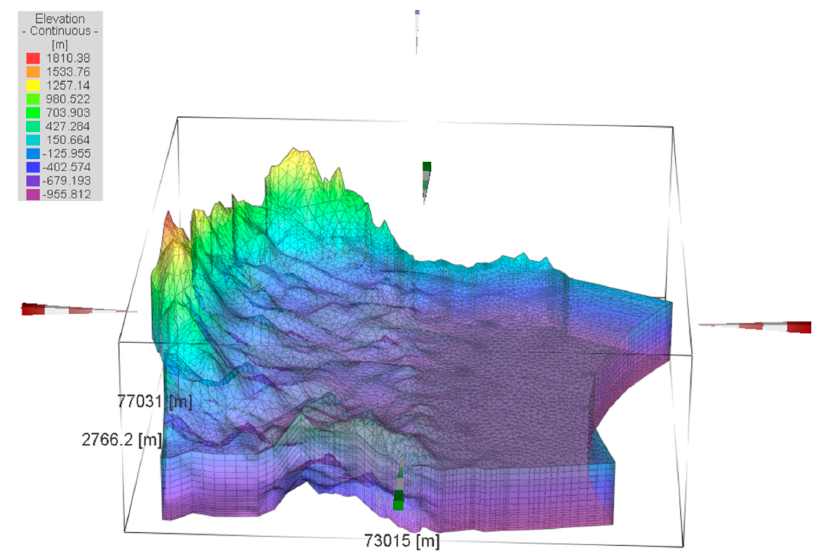
Figure 2. Three-dimensional (3D) groundwater flow and heat transport model of the Sendai Plain (reginal model) quoted from Kaneko et al. [21]. Table 1. Input parameters of the regional model of the Sendai Plain quoted from Kaneko et al. [21].